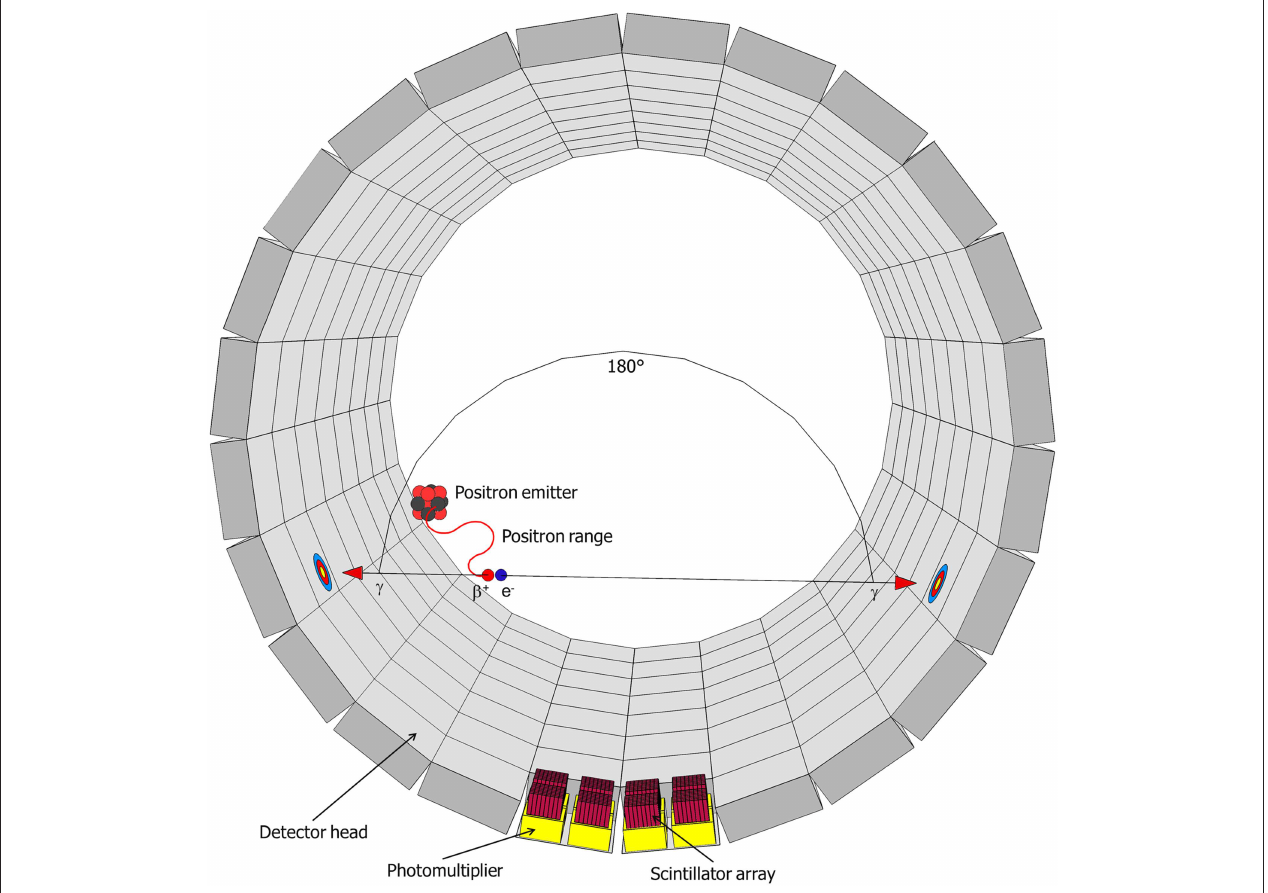
FIGURE 3 | Schematic representation of a decaying radionuclide emitting a positron ( β + ), which will collide with an electron (e − ) after traveling a certain distance (positron range) resulting in the annihilation with the emission of two gamma-rays ( γ ) in opposite direction. This radiation will be detected in the detector head by a scintillator and the resulting signal is enhanced by photomultipliers (after Hubeau and Steppe, 2015 with the permission of Copyright Clearance